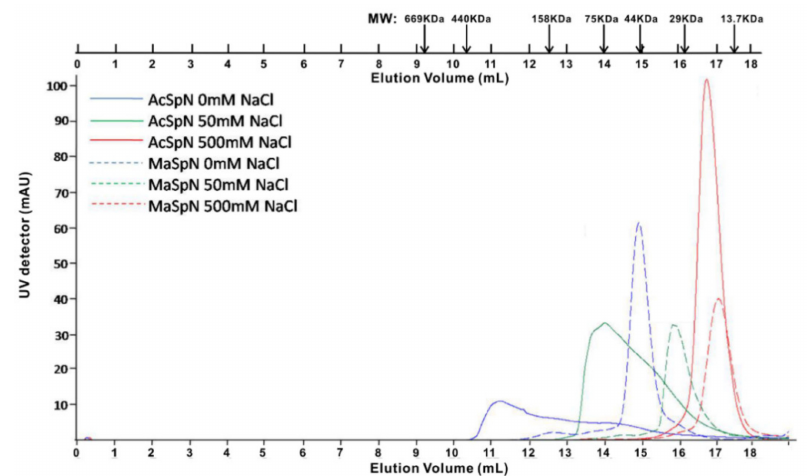
Figure 2. Size exclusion chromatograms of AcSpN and MaSpN at pH 7.0 and three di ff erent NaCl concentrations. The molecular weight markers of standards are placed on the top of the experimental